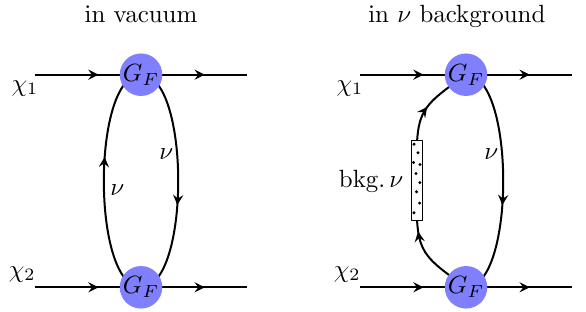
Figure 1 . A diagrammatic explanation of neutrino forces in the vacuum (left) and in a neutrino background (right). The background effect can be taken into account by replacing one of the neutrino propagators with a background-modified propagator (bkg. ν ), which can be computed in finite temperature field theory. The effect can be physically interpreted as absorbing a neutrino from the background and then returning it back to the